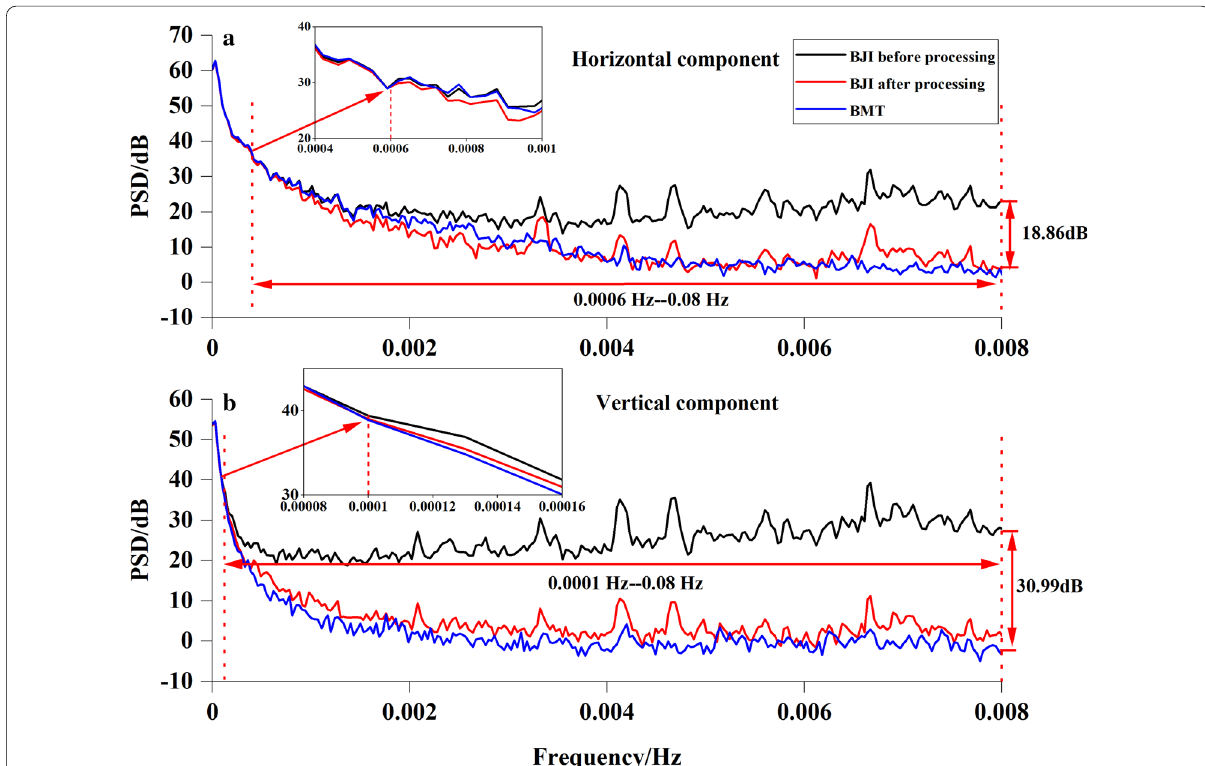
Fig. 2 Power spectra density of the raw data collected at BJI (black line), the processed data by the adaptive Kalman filter (red line) and data at BMT (blue line). a Horizontal component. b Vertical component. Insets show details of PSD at low frequencies